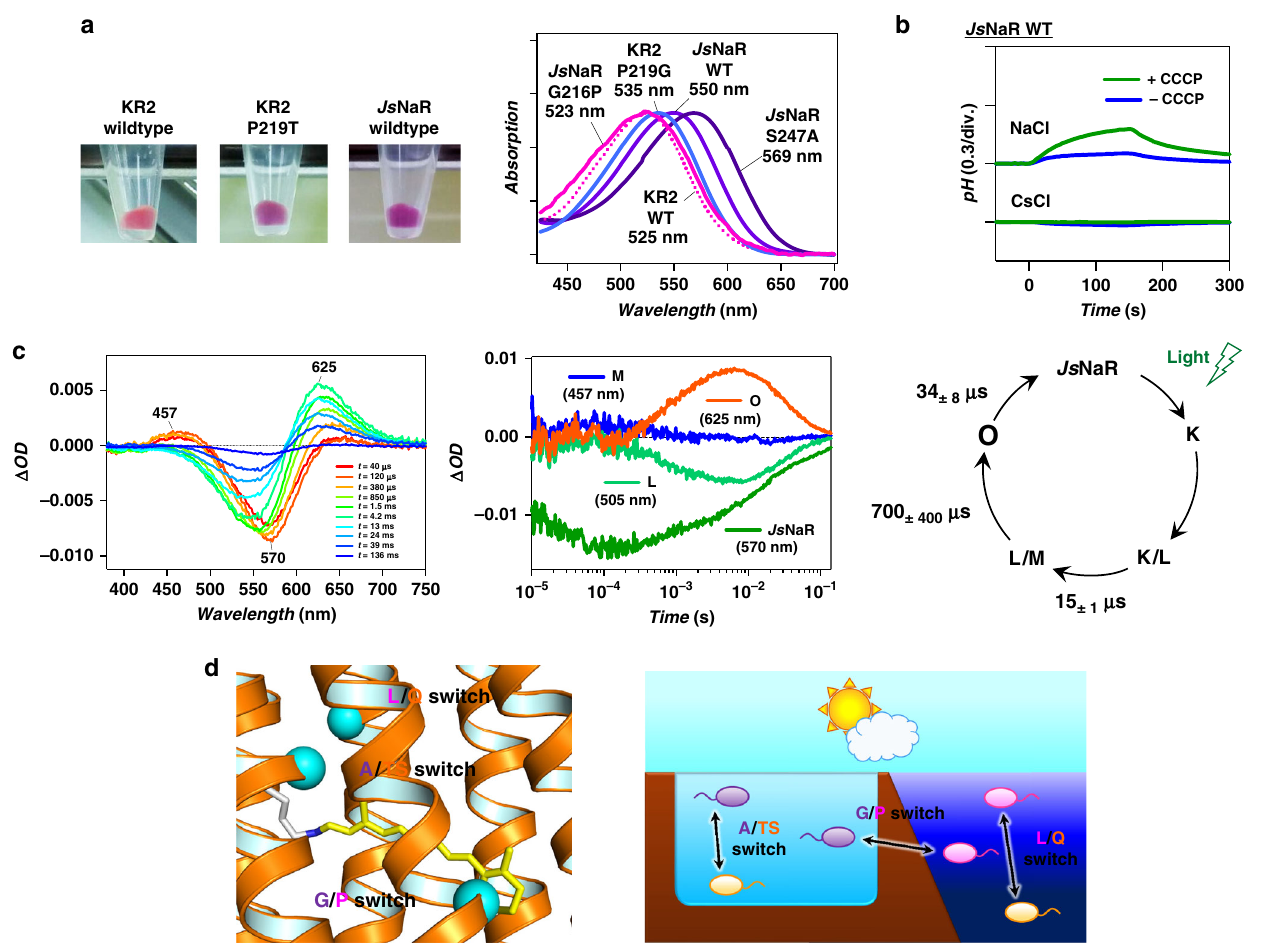
Fig. 7 The natural red-shifted NaR from J. seosinensis ( Js NaR) without proline residue. a Pictures of the pellets of the E. coli cells expressing the KR2 wildtype, P219T, and Js NaR wildtype (left) and the absorption spectra of Js NaR wildtype (purple solid line), G216P (magenta solid line), and S247A mutants (indigo solid line). The absorption spectrum of KR2 wildtype and P219G mutant are shown by the magenta dotted line and cyan solid line, respectively. b Ion pump activity assays of the Js NaR wildtype. c The transient absorption spectra (left), time evolutions of the transient absorption change at speci fi c wavelengths (middle) and the photocycle (right) of the Js NaR wildtype. The lifetimes and their standard deviations of the photo-intermediates in the photocycle of Js NaR are indicated. Source data are provided as a Source Data fi le. d The residues for colour regulating switches in microbial rhodopsins indicated by cyan spheres (left) and three types of switch working in various bacteria and archaea living in various environments in